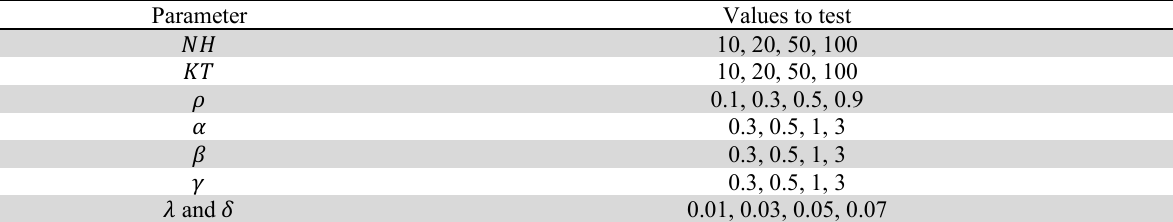
Parameter settings used in parameter values